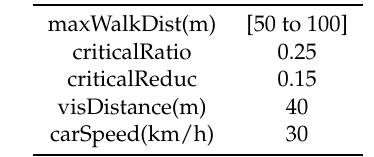
Table 1. Model parameters